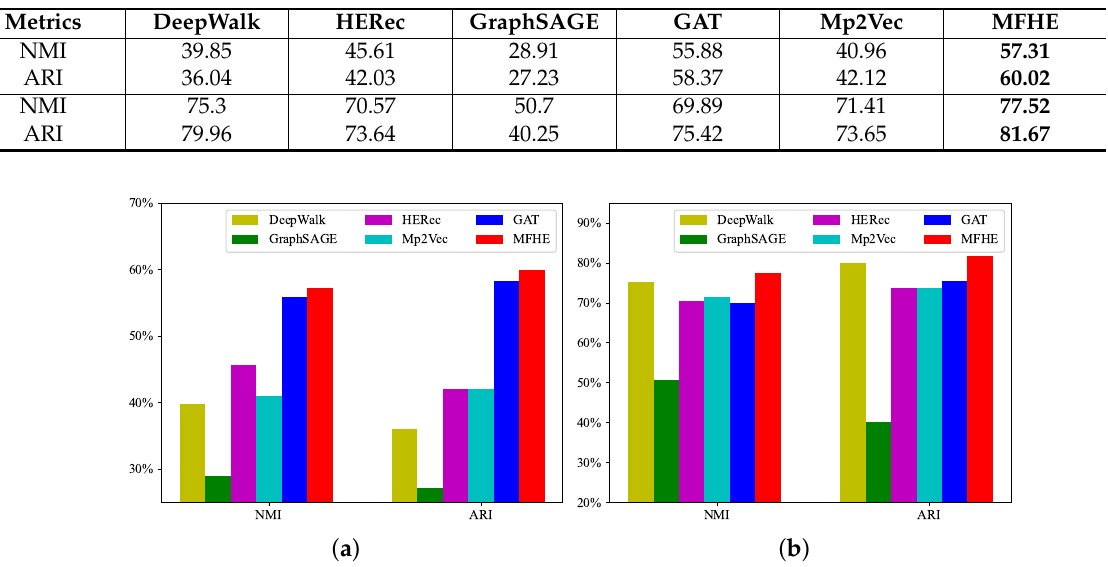
Table 5. Results of the node clustering task (%).